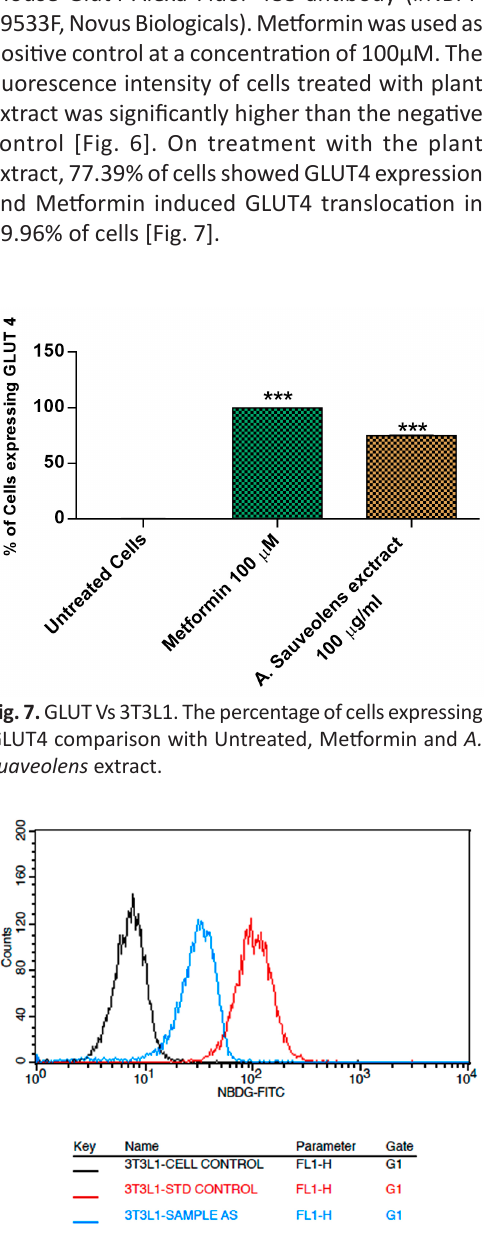
Fig. 8. Overlaid expression of given untreated 3T3L1 cells (black colour line) & standard drug treated cells (metformin 100um) (red colour line) and test compound treated cells (cyan colour line) against the 2-nbdg